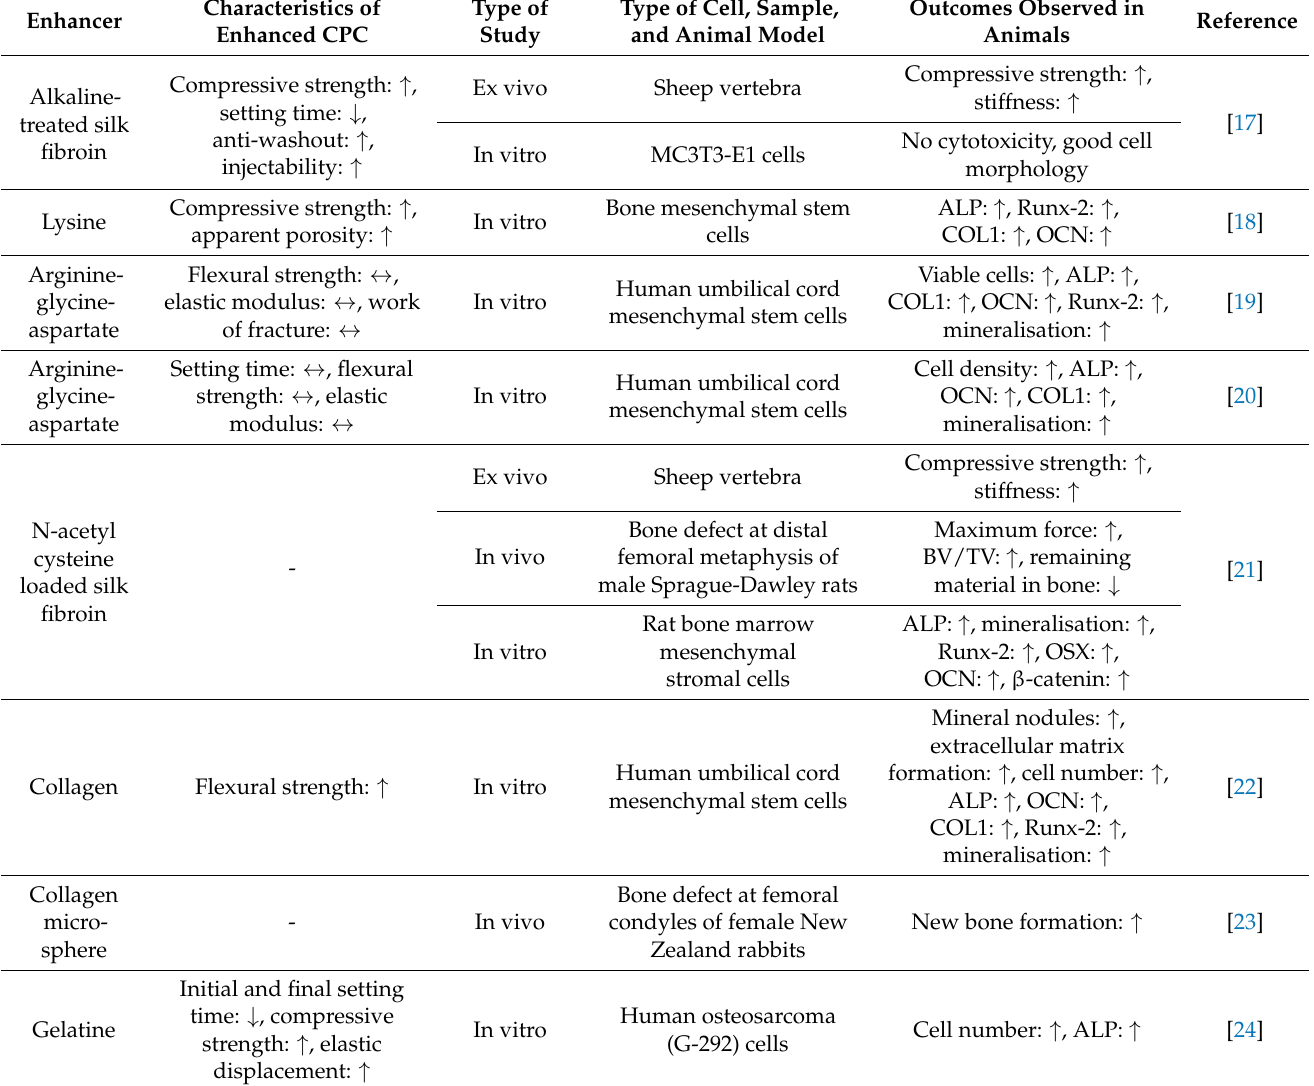
Table 3. The bone protecting effects of CPC enhanced by